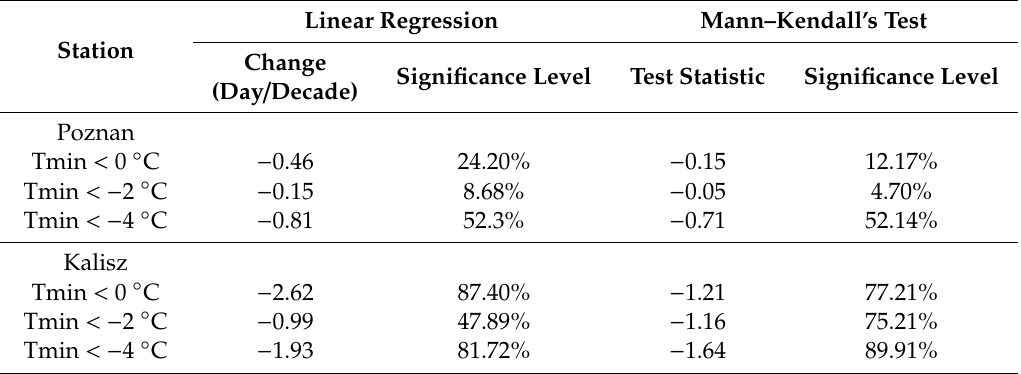
Table 4. Trend characteristics of the last spring ground frosts date in relation to the growing season